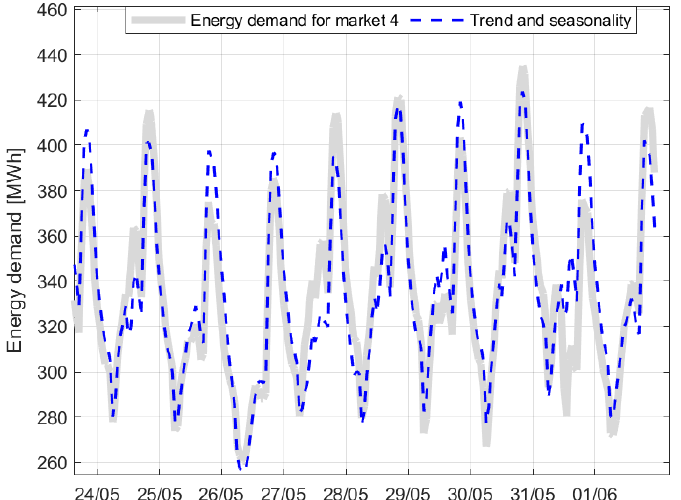
Figure 6. Daily energy demand for Market 4 between 24 May 2018 – 1 June 2018.